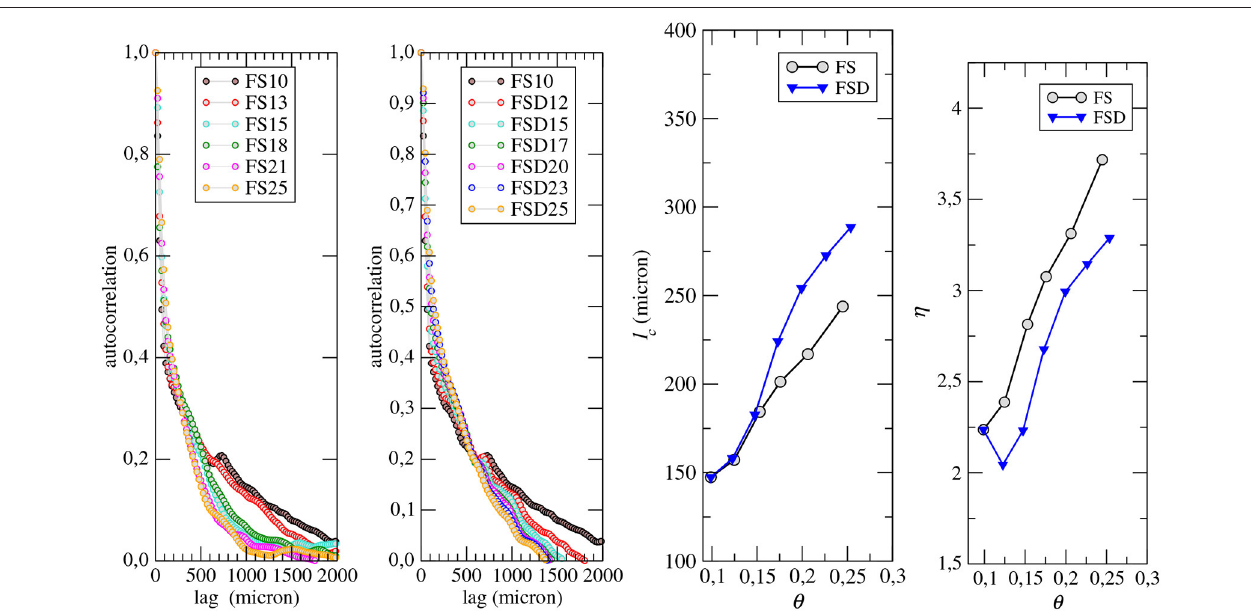
( l ) for the FS (left) and the FSD (middle-left) samples. The middle-right panel displays v